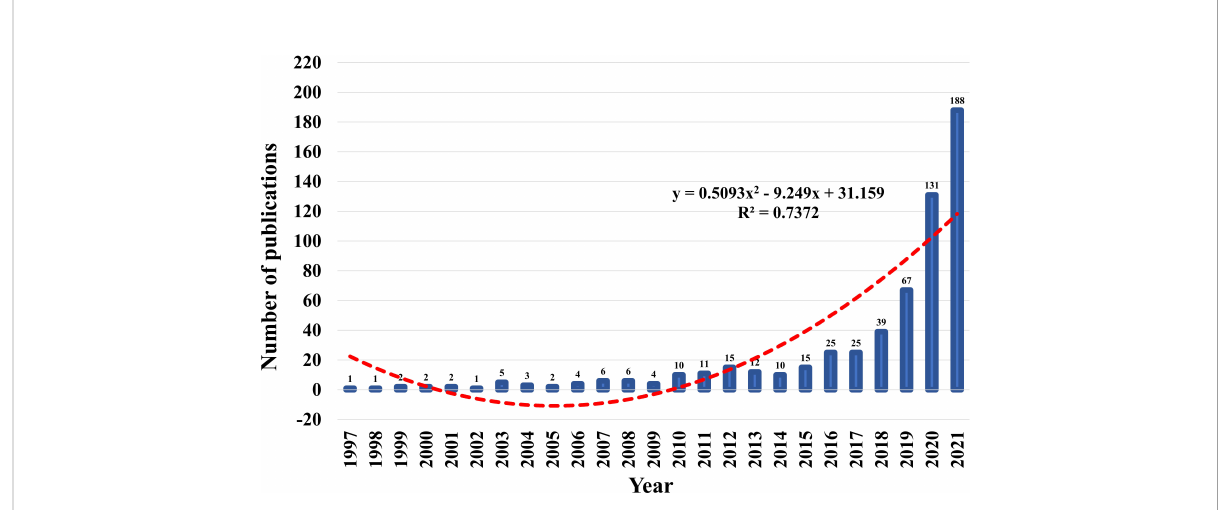
FIGURE 2 Trends of annual publications on research of AI in pancreatic cancer and the polynomial fi tted curves (red dotted line).